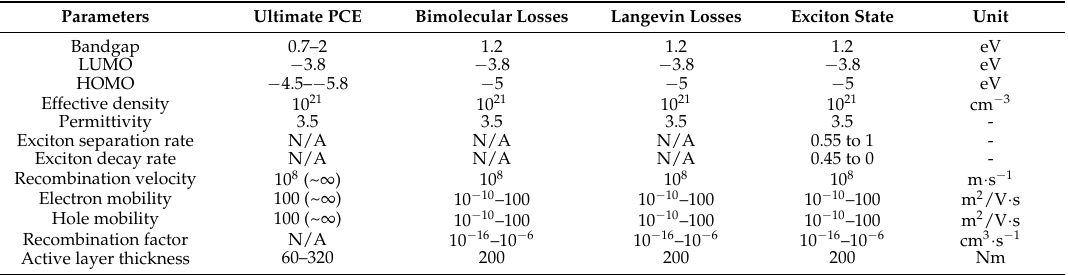
Table 1. Basic set of parameters used for estimating ultimate power conversion efficiency (PCE) for different physical processes. N/A: not